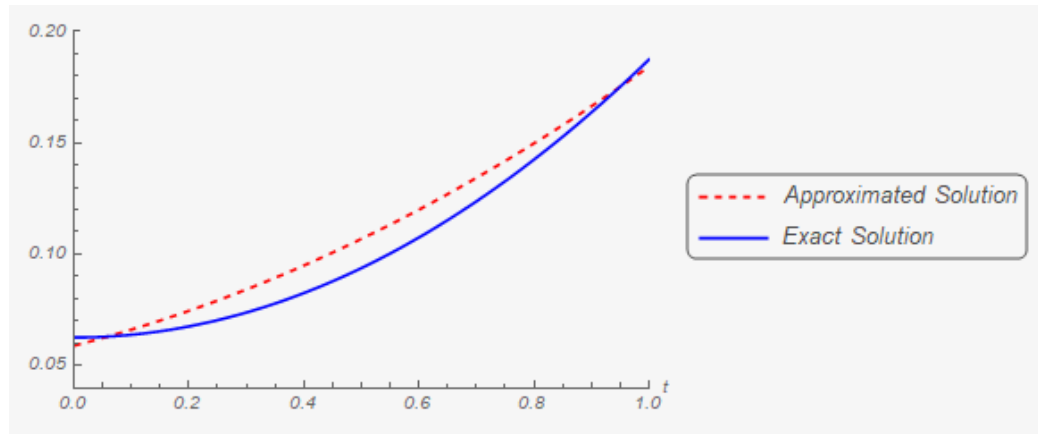
Figure 5. The first component of the exact solution and its hundredth approximation.